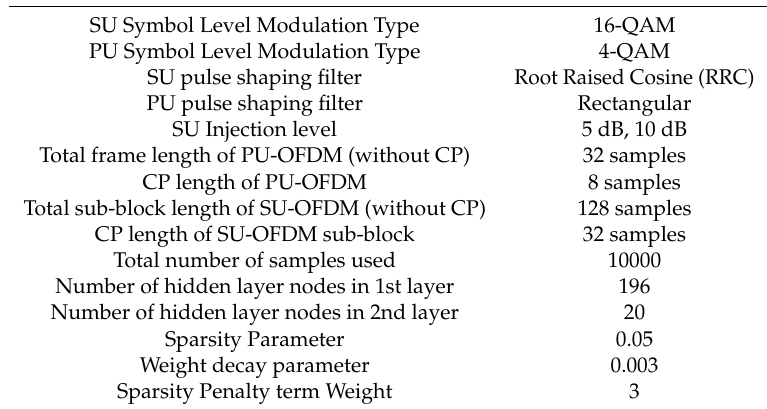
Table 2. Simulation Parameters.